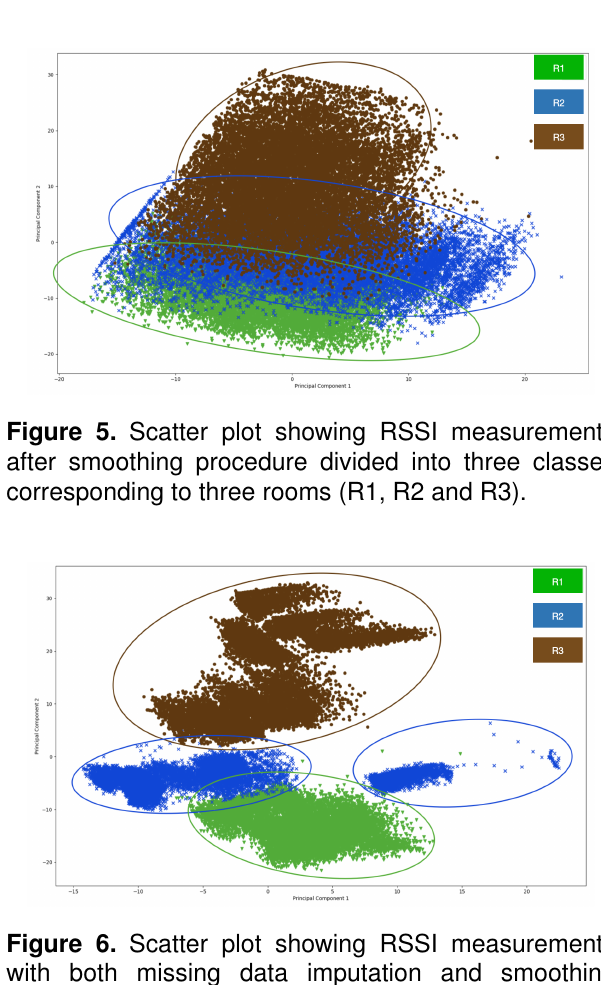
algorithms and the algorithm accuracy was evaluated against the testing data set.